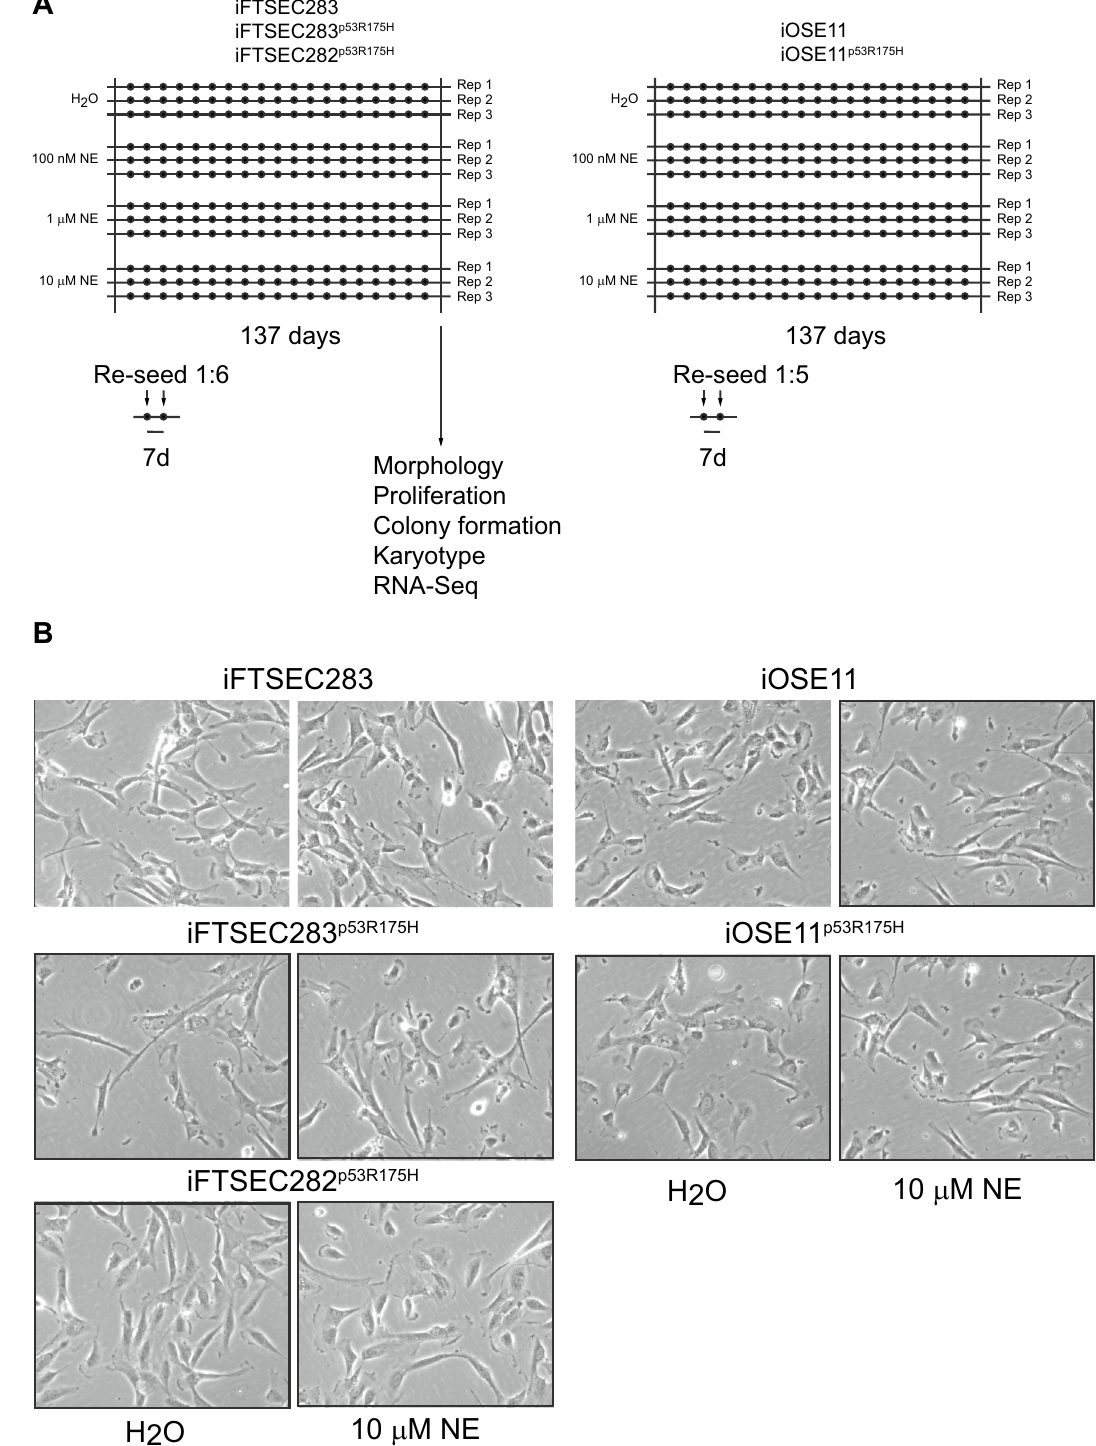
Figure 1. Experimental design of long-term treatment. ( A ) Diagram of the experimental design representing each independent replicate and different treatments. Black dots represent subculturing by trypsinization and re-seeding. ( B ) Phase contrast microscopy showing cell morphology under phase contrast microscopy at the end of the treatment